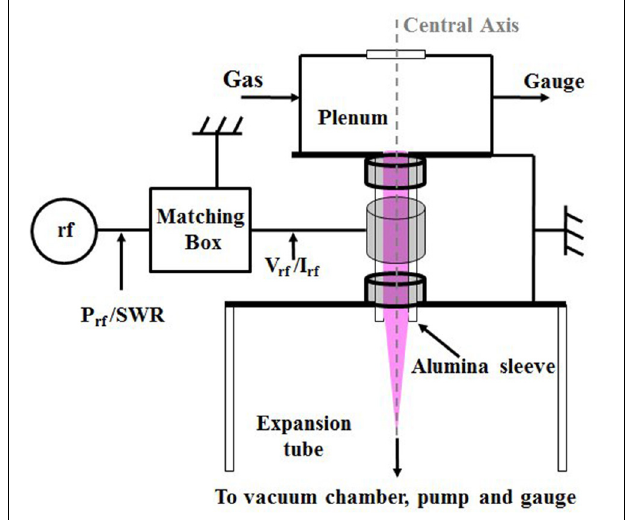
FIGURE 1 | The physical Pocket Rocket